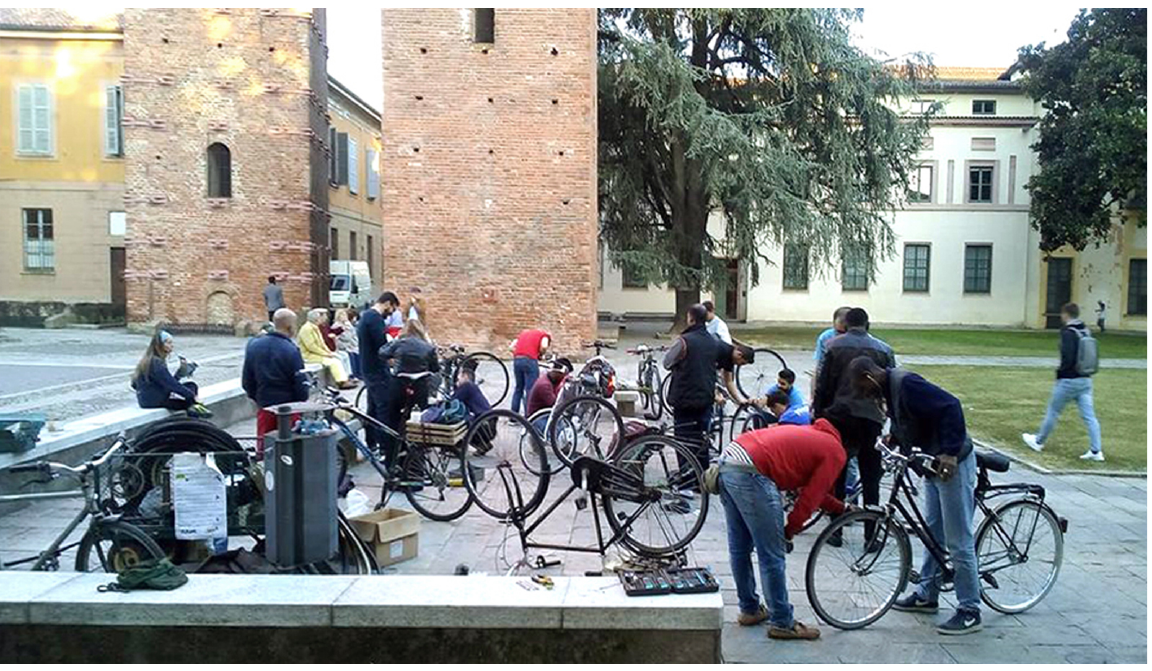
Piazza Leonardo da Vinci, bike repair session and temporary uses during the Giocanda Festival (photo no. 13 by Ciclofficina Pavia, photo no.14 by Giocanda Festival).